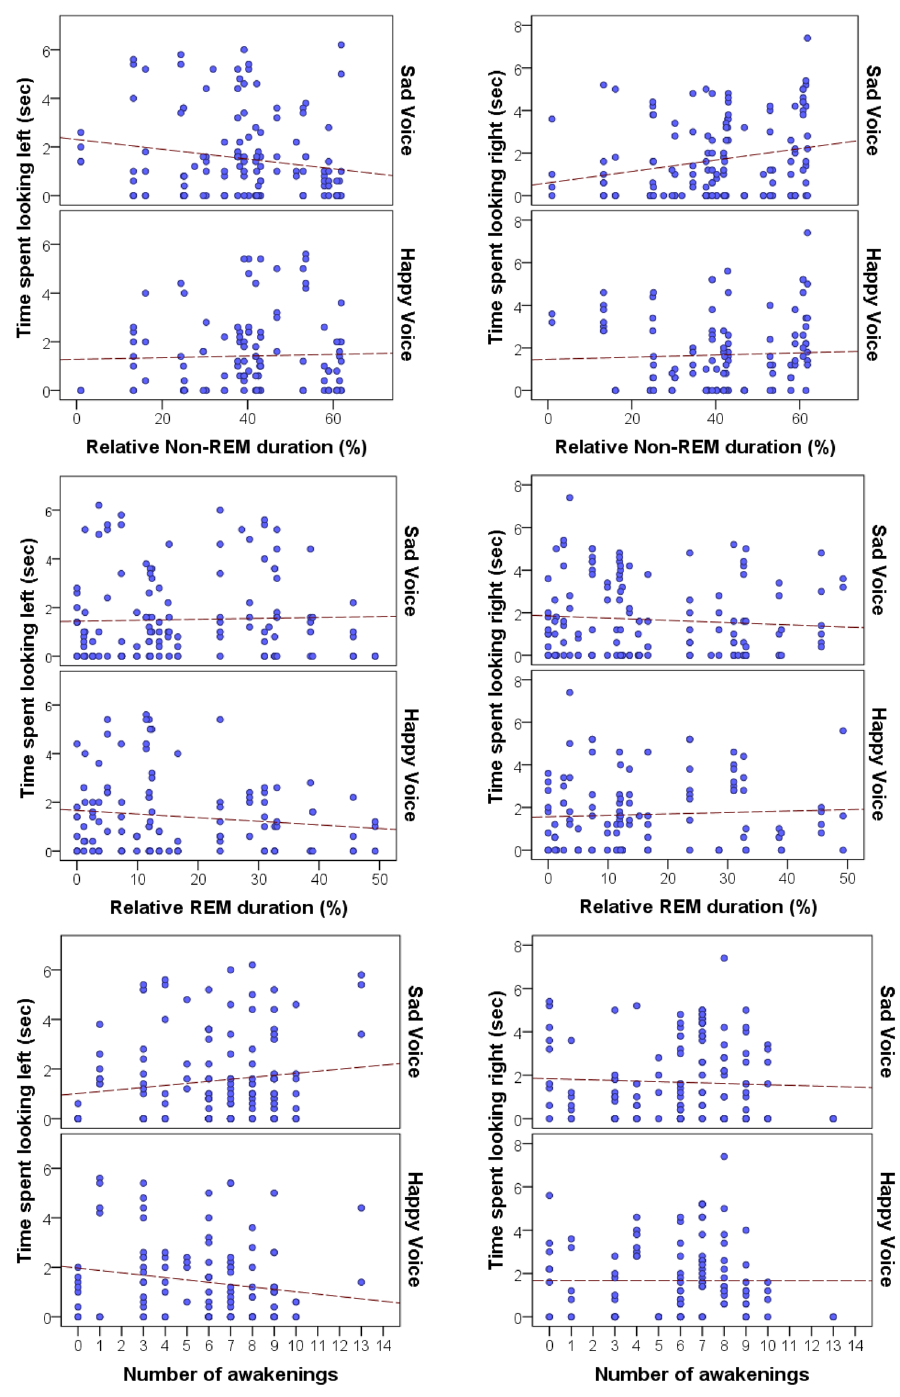
Figure 3. The associations between looking behaviour (left or right) and sleep macrostructure